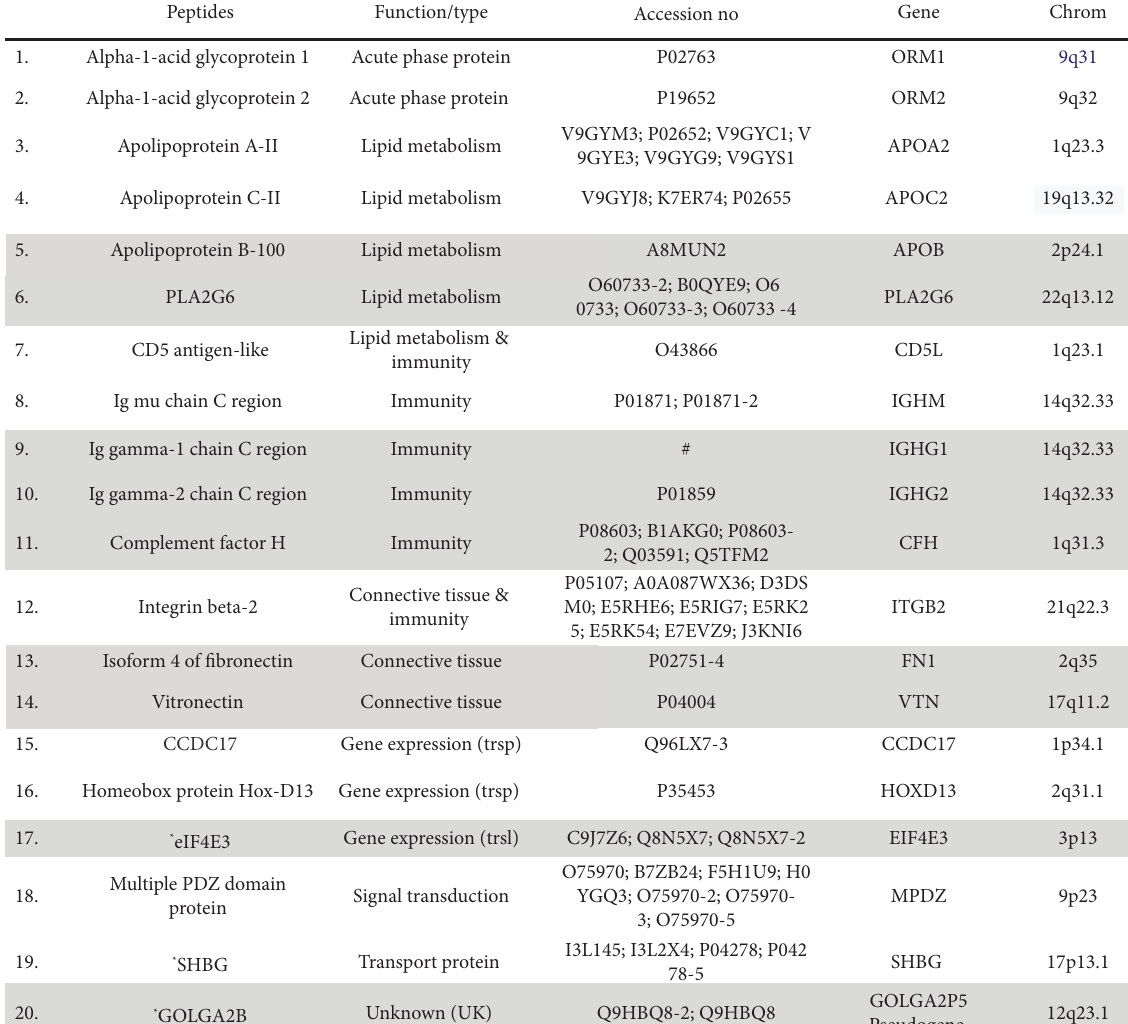
Table 2: List of upregulated proteins/peptides (PP)s in healthy men (grey shadow) and women, showing the PP category, accession number, gene, and gene chromosomal